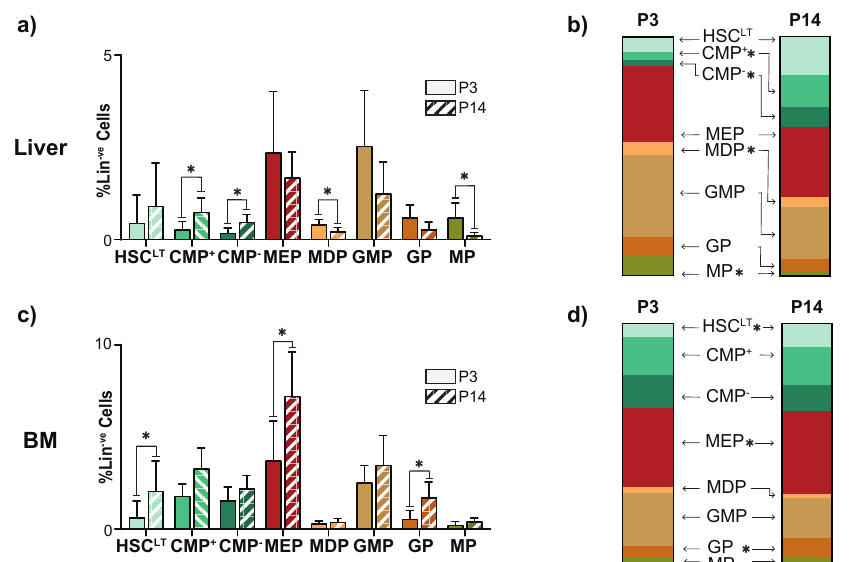
Figure 2. The juvenile mouse liver retains common myeloid progenitors. Percentage of hematopoietic Figure 2 : The juvenile mouse liver retains common myeloid progenitors. stem cell (HSC LT ), common myeloid progenitor (CMP), and terminal myeloid progenitor (TMP) Percentage of hematopoietic stem cell (HSC LT ), common myeloid progenitor populations among lineage negative (Lin − ve ) cells in ( a ) liver and ( c ) bone marrow (BM) on postnatal (CMP), and terminal myeloid progenitor (TMP) populations among lineage negative day 3 (P3) and postnatal day 14 (P14). Relative proportions of HSC LT , CMP, and TMP among (Lin -ve ) cells in (a) liver and (c) bone marrow (BM) on postnatal day 3 (P3) and HSC LT and their downstream myeloid progenitors in the ( b ) liver and ( d ) BM (P3, P14, n = 6). postnatal day 14 (P14). Relative proportions of HSC LT , CMP, and TMP among p -value * < 0.05. Error bars represent the mean ± HSC LT and their downstream myeloid progenitors in the (b) liver and (d) BM (P3, P14, n=6). p-value *<0.05. Error bars represent the mean ± SD.